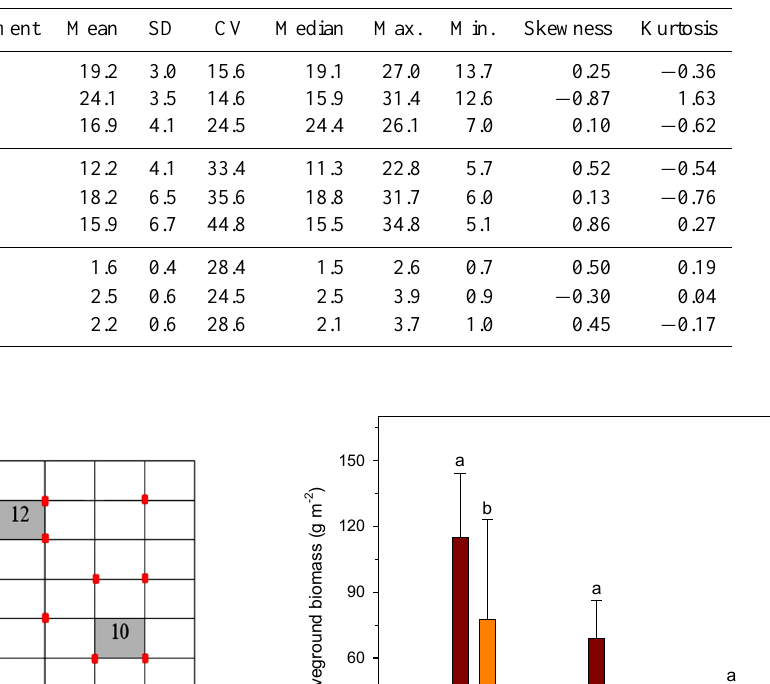
Table 2. Statistical characteristics of soil properties at sites exposed to different grazing intensities (UG–ungrazed, MG–moderate grazing and HG–heavy grazing).